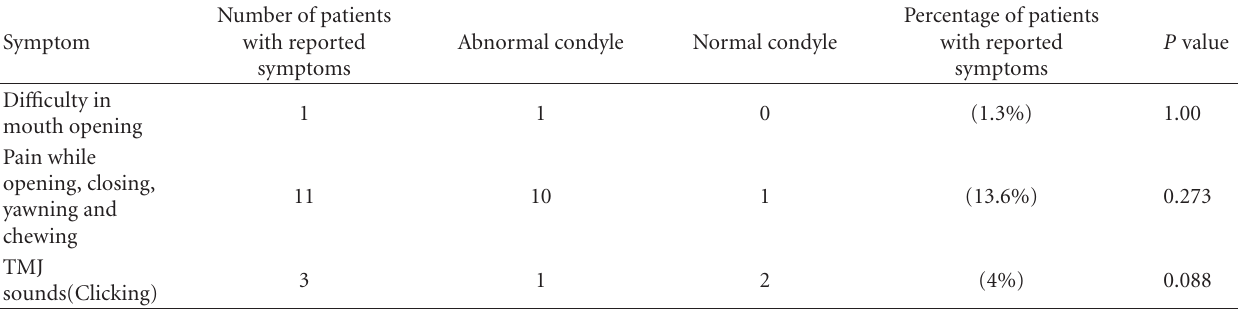
Table 5: Correlation between symptoms and radiographic changes in condyles.